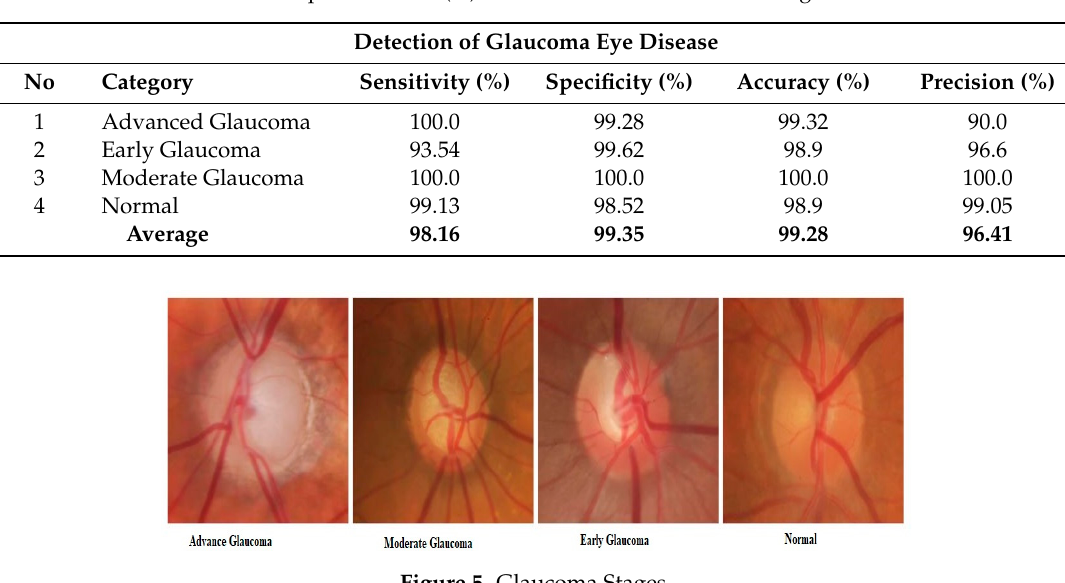
Table 4. Computed Values (%) of Statistical Measures on Testing Dataset.